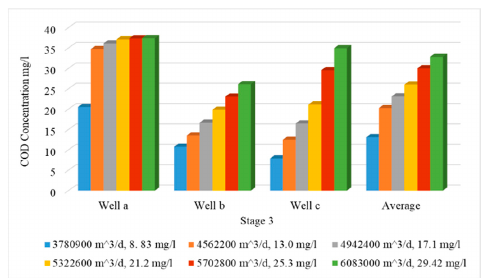
Figure 11. Comparison between COD concentration at observation wells for different scenarios (12–16) of stage 3.